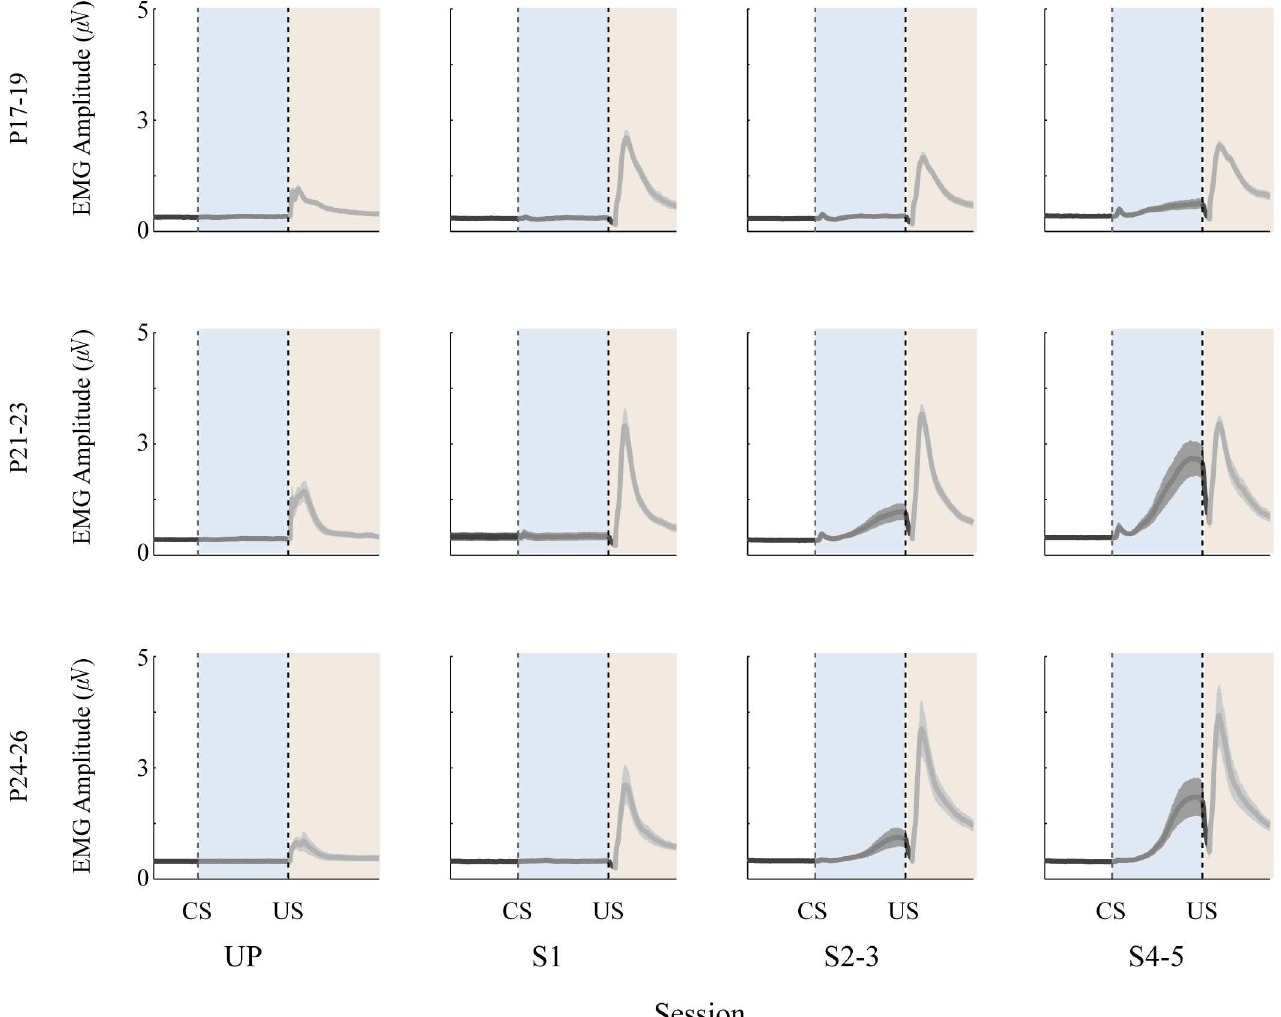
Fig 2. Population mean (+/- SE) eyelid EMG tracesfor rat pups given delay eyeblink conditioning. The vertical dotted lines indicate CS and US onsets. Note that responses during the CS and US in the unpaired(UP) session were plotted together for visualization. EMG amplitudeduring the CS period increasedacross paired sessions (S1, S2-3, and S4-5) in all age groups. However, these increases were more evident in the older two age groups. The drop in EMG activity between the CS period and the post-US period is caused by gating the amplifier during the US to prevent recording a stimulation